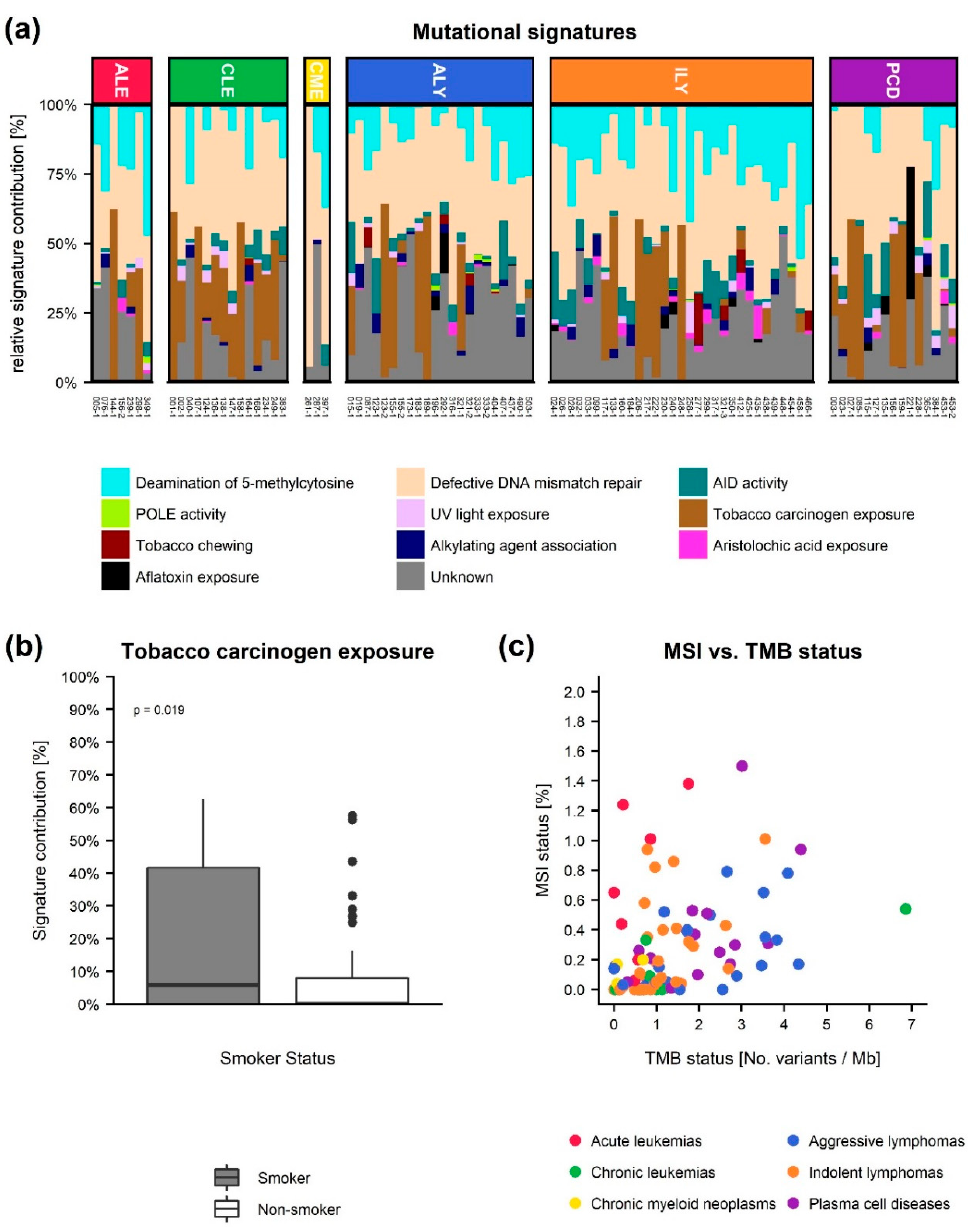
Figure 6. Other potential clinically relevant genomic measurements. ( a ) The relative contribution of the COMSIC mutational signatures to each tumor sample grouped as either Deamination of